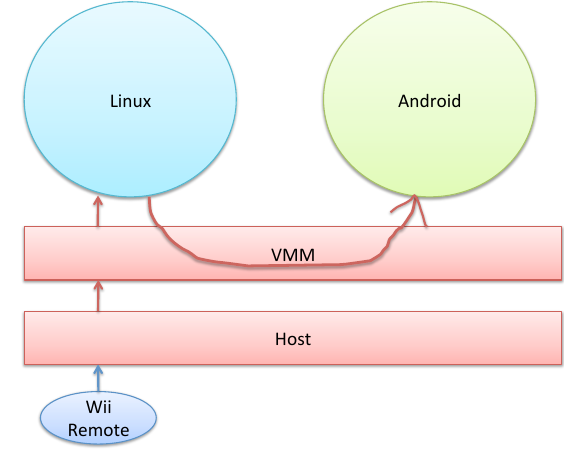
Fig. 11. virtualized